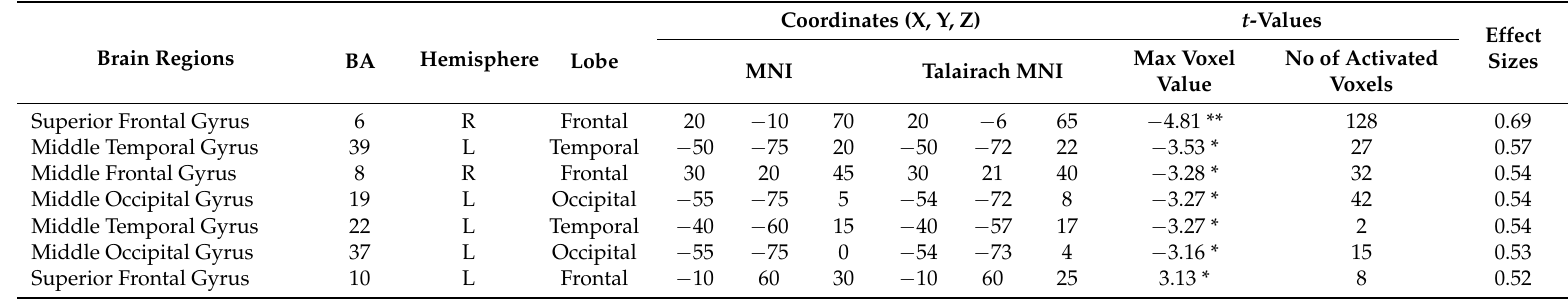
Table 5. Standardized low-resolution brain electromagnetic tomography (sLORETA) results of maximal brain electrical activity for the Control vs BFRB group difference (at 356 ms latency).